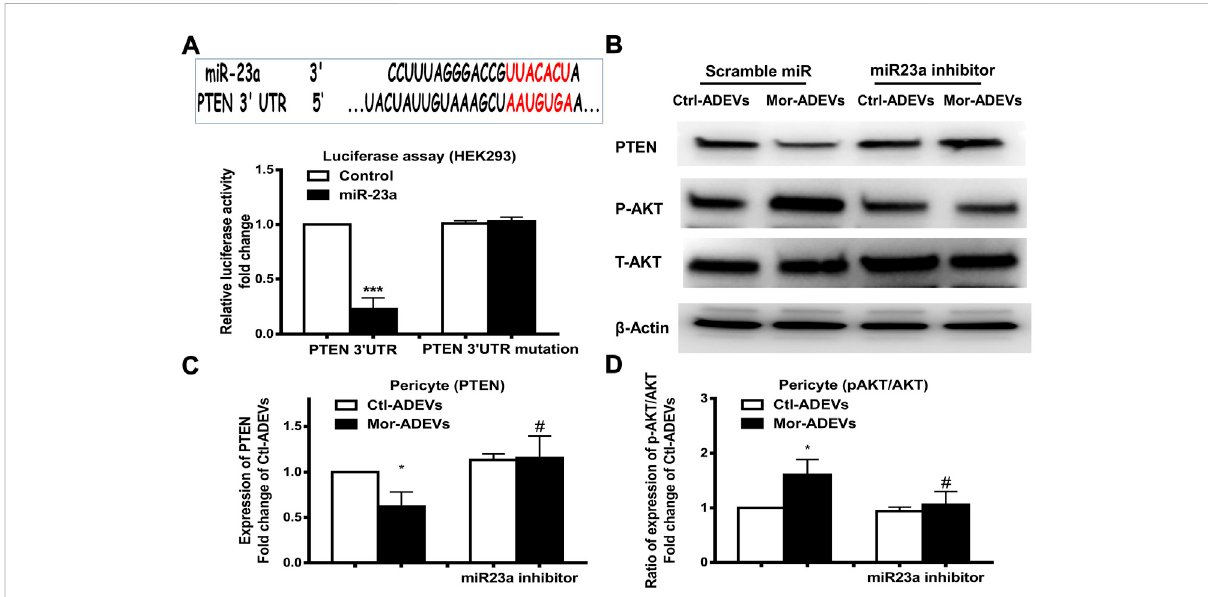
FIGURE 6 ADEVs-miR-23a targets PTEN that leads to activation of the AKT pathway. (A) Putative miR-23a binding site in PTEN mRNA. Relative luciferase activityofWTand3 ′ UTRmutantconstructsofPTENinHEK293cellsco-transfected withmiR-controlormiR-23amimic. (B) Representativewestern blot and quanti fi cation of PTEN (C) , AKT and p-AKT (D) protein levels in pericytes transfected with either control-miR or miR-23a mimics for 24 h, followed by treatment of ctl-ADEVs or morphine-ADEVs. Each set of results was quanti fi ed upon three independent experiments. All data are presented as mean ± SD, * p < 0.05, *** p < 0.001 vs. ctl-ADVs group; # p < 0.05 vs. morphine-ADEVs group using one-way ANOVA